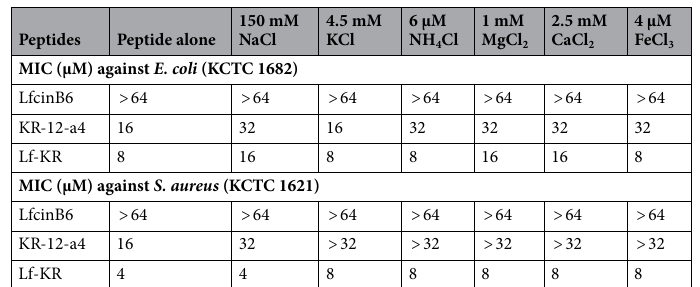
Peptides Peptide alone